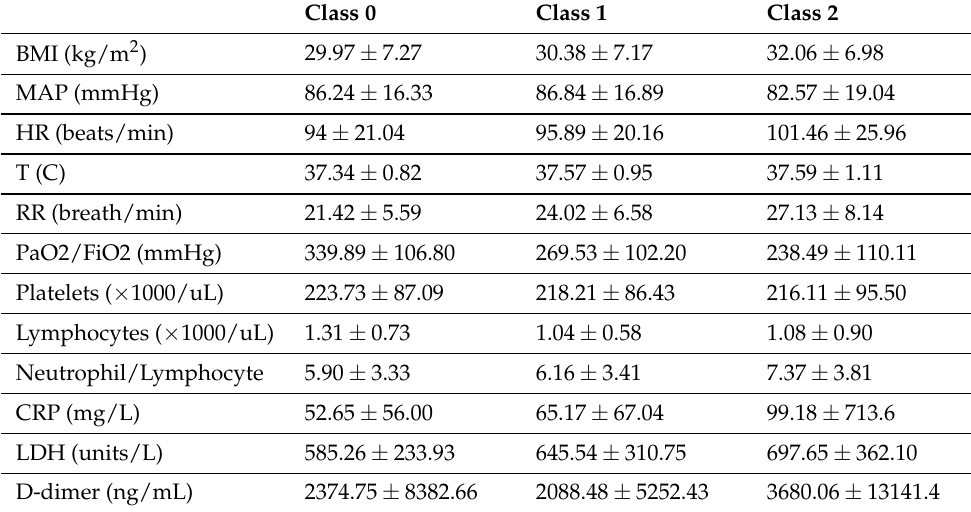
Table 1. The mean and standard deviation of the 12 features across the three